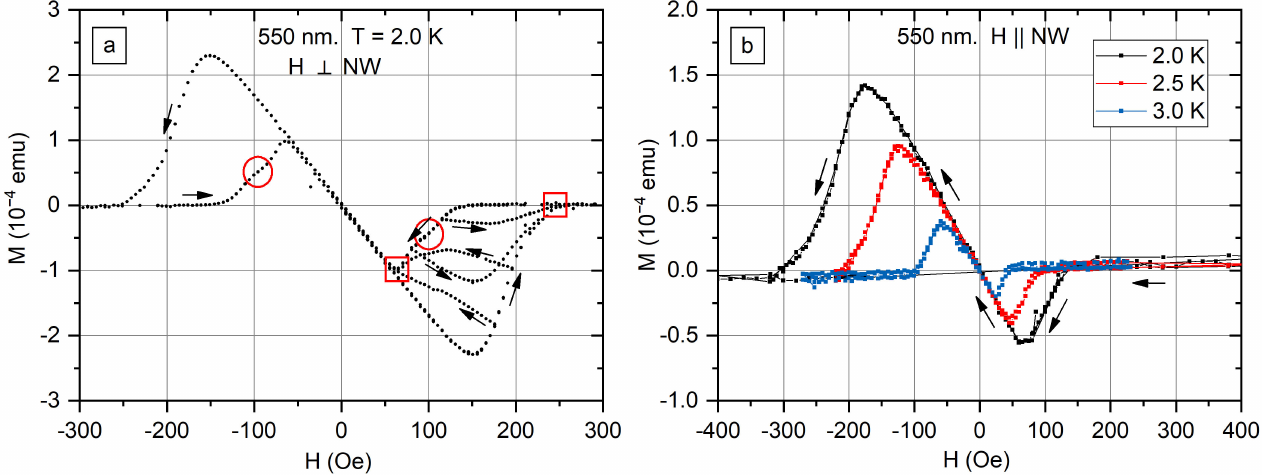
Figure 6. The magnetic moment M of 550-nm-diameter In nanowire array as a function of transverse ( a ) and axial ( b ) magnetic field H . Arrows show how the field was changing. Two joining points of minor loops are marked with red squares. The feature of the M ( H ) curve in the transverse field, which is absent in case of axial field, is marked with the red circle in panel ( a